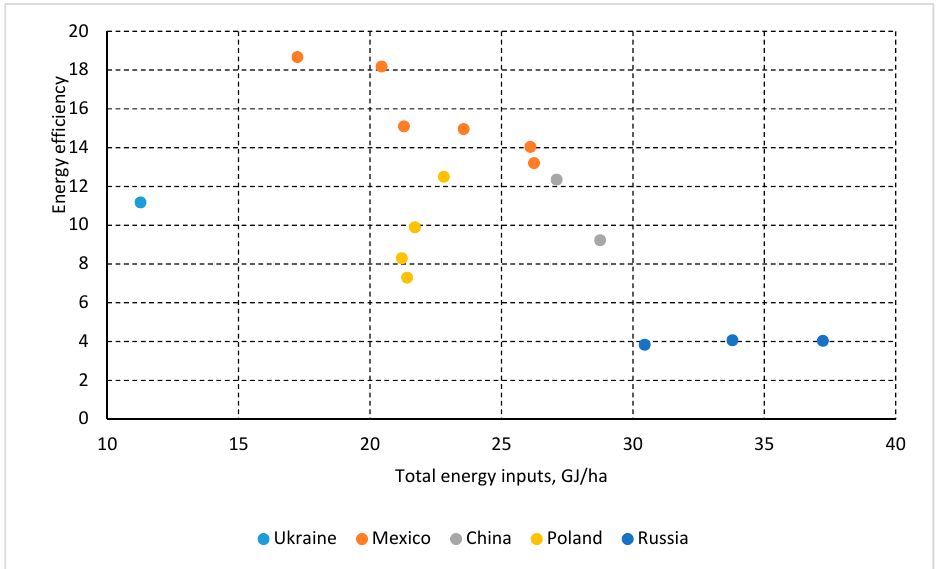
Figure 9. Energy efficiency ratio.